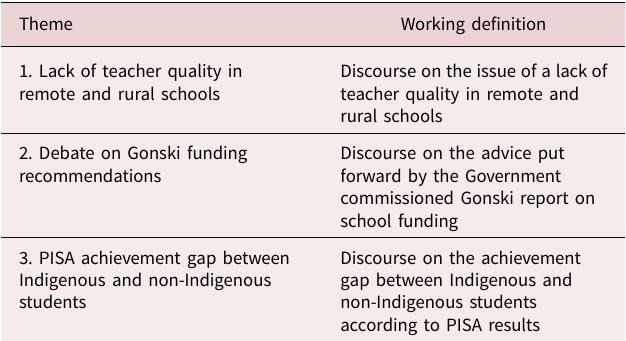
Table 5. Outline of the central concept and boundaries attributed to each of the three themes for this thematic